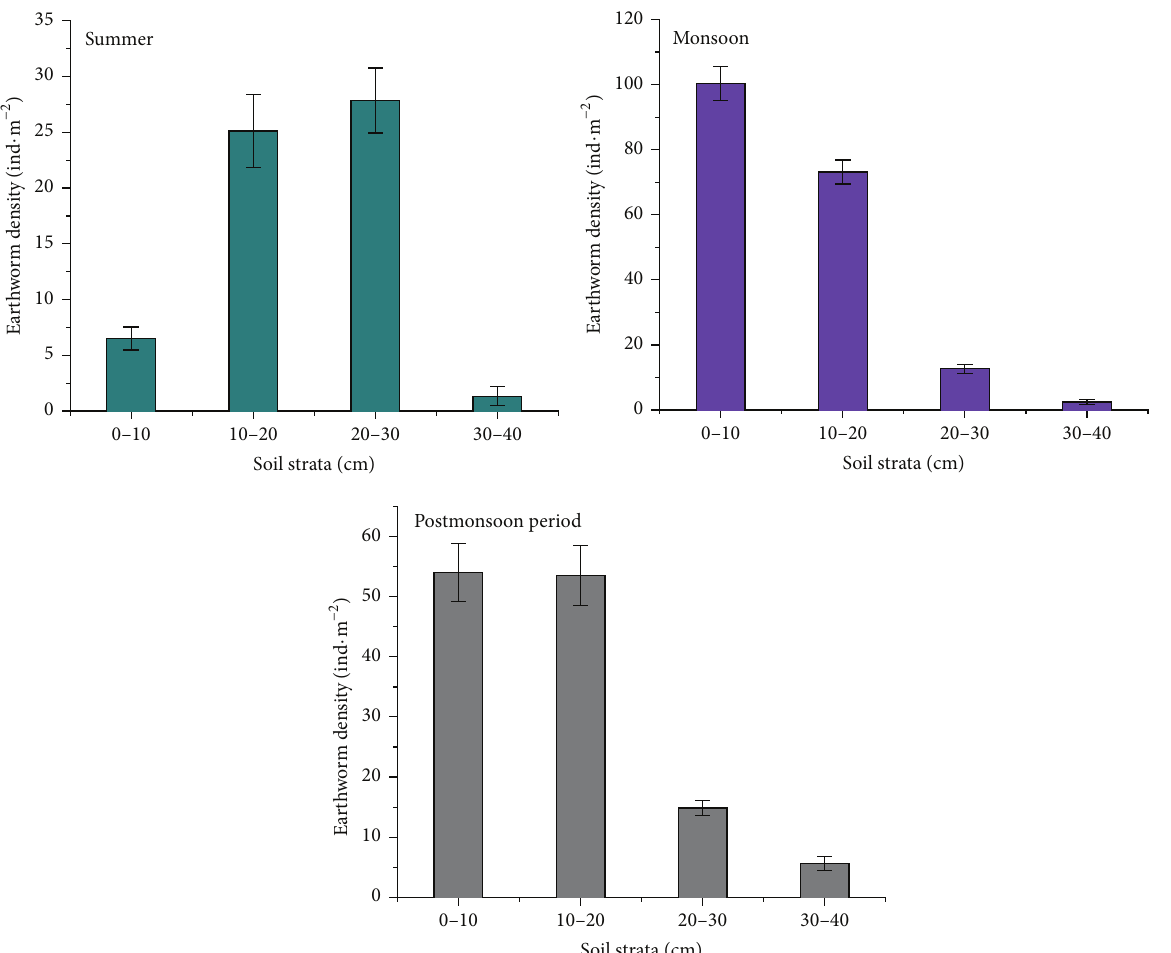
Figure 6: Showing the influence of seasonality on the vertical distribution of earthworm community in the pineapple plantations of Tripura.